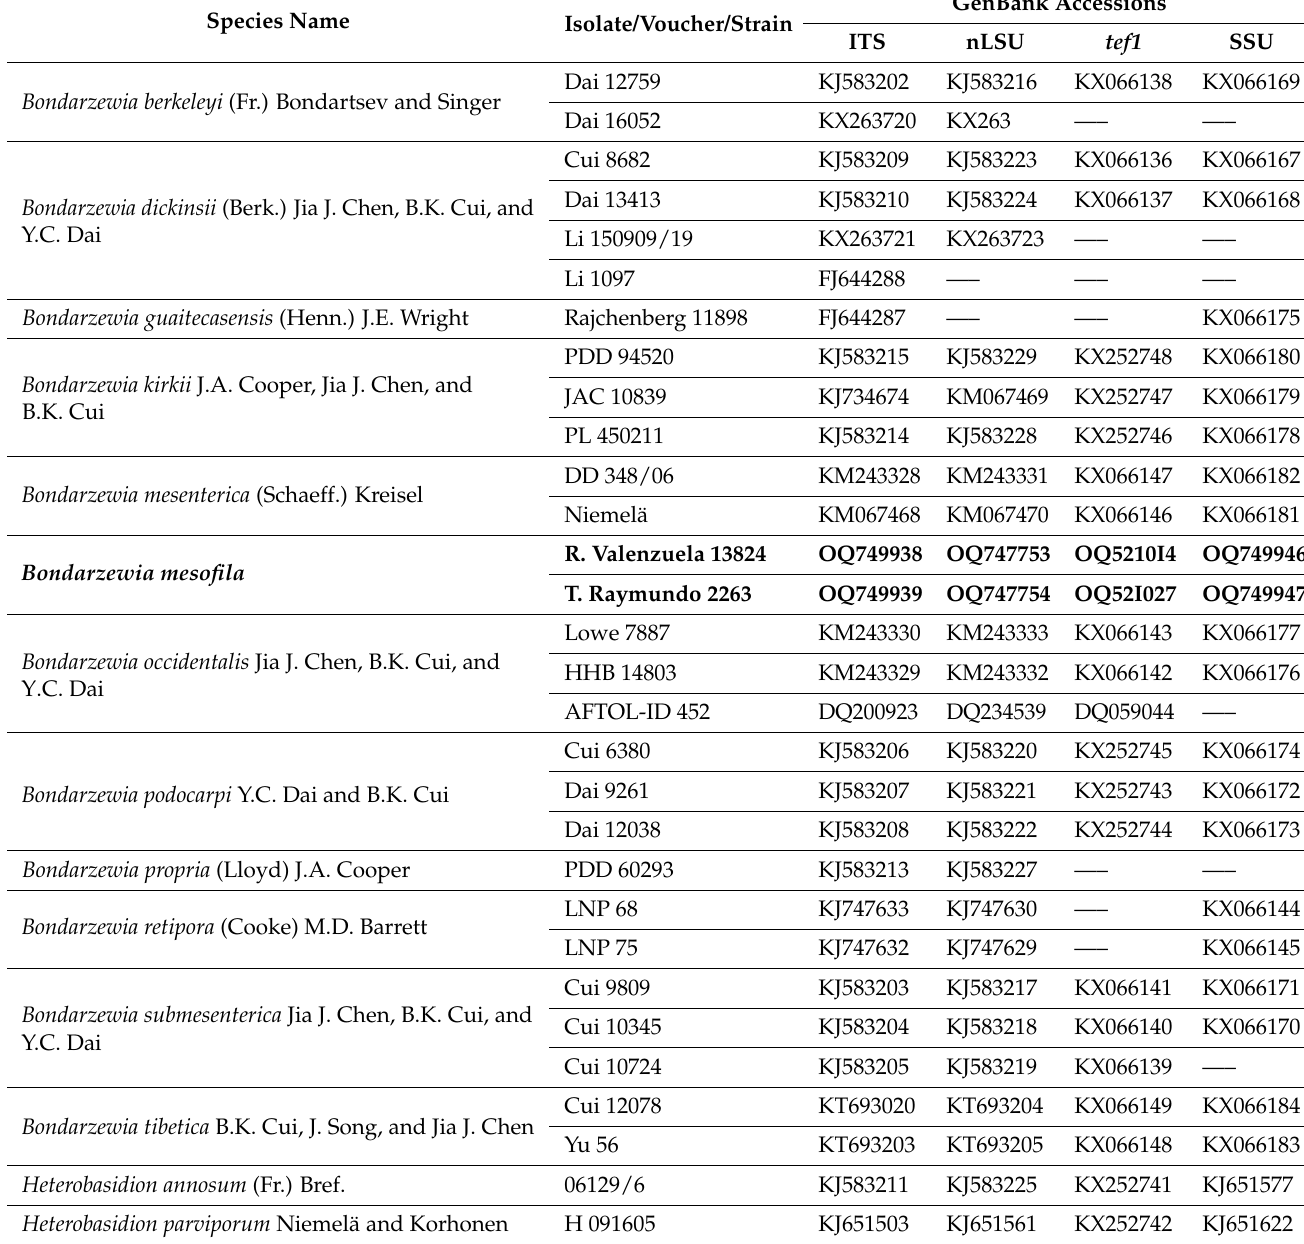
Table 5. GenbBank accessions corresponding to the Bondarzewia sequences used in the phylogenetic analyses. In bold, the accessions of the new